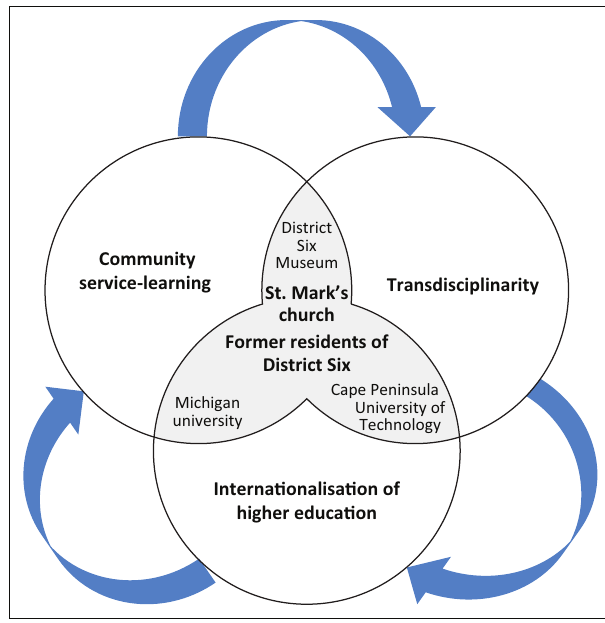
FIGURE 1 : Nexus between service-learning, transdisciplinary education and